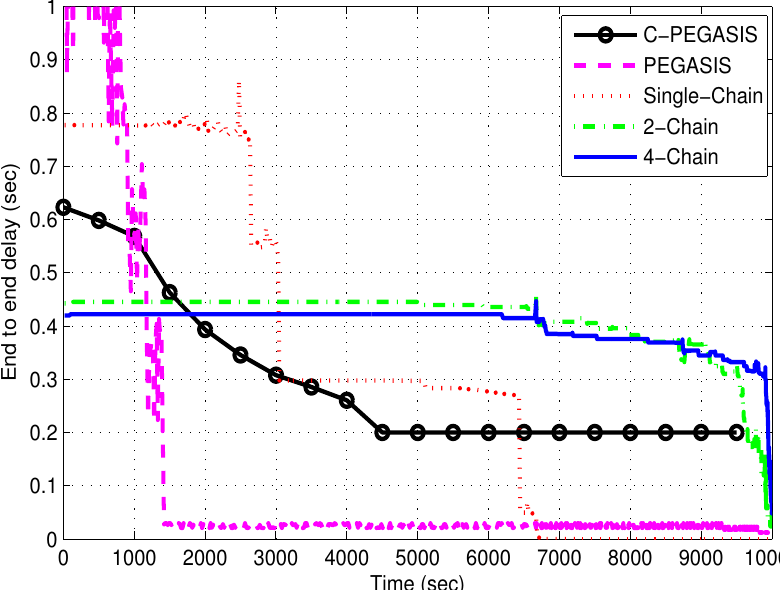
Figure 9. End-to-end delay (sec) in 4-chain, 2-chain, single chain-based routing and